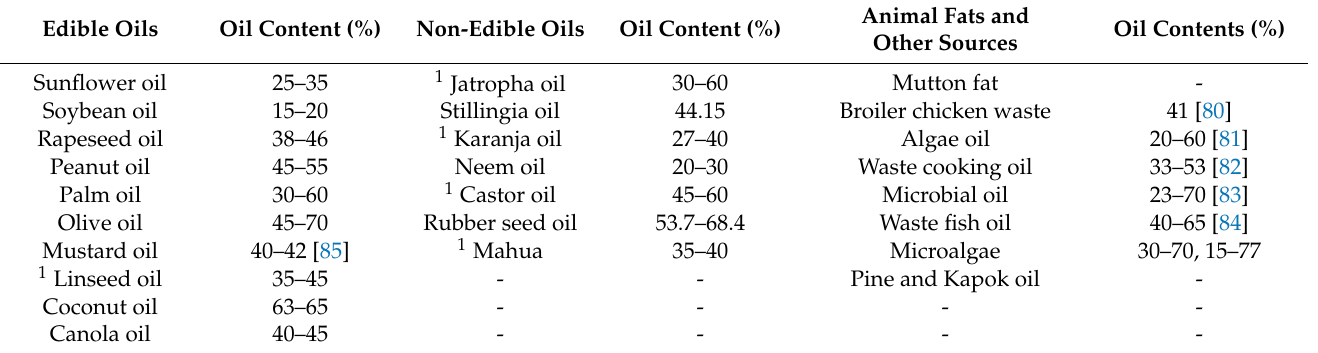
Table 3. Different sources of feedstocks/raw materials are used for the production of biodiesel